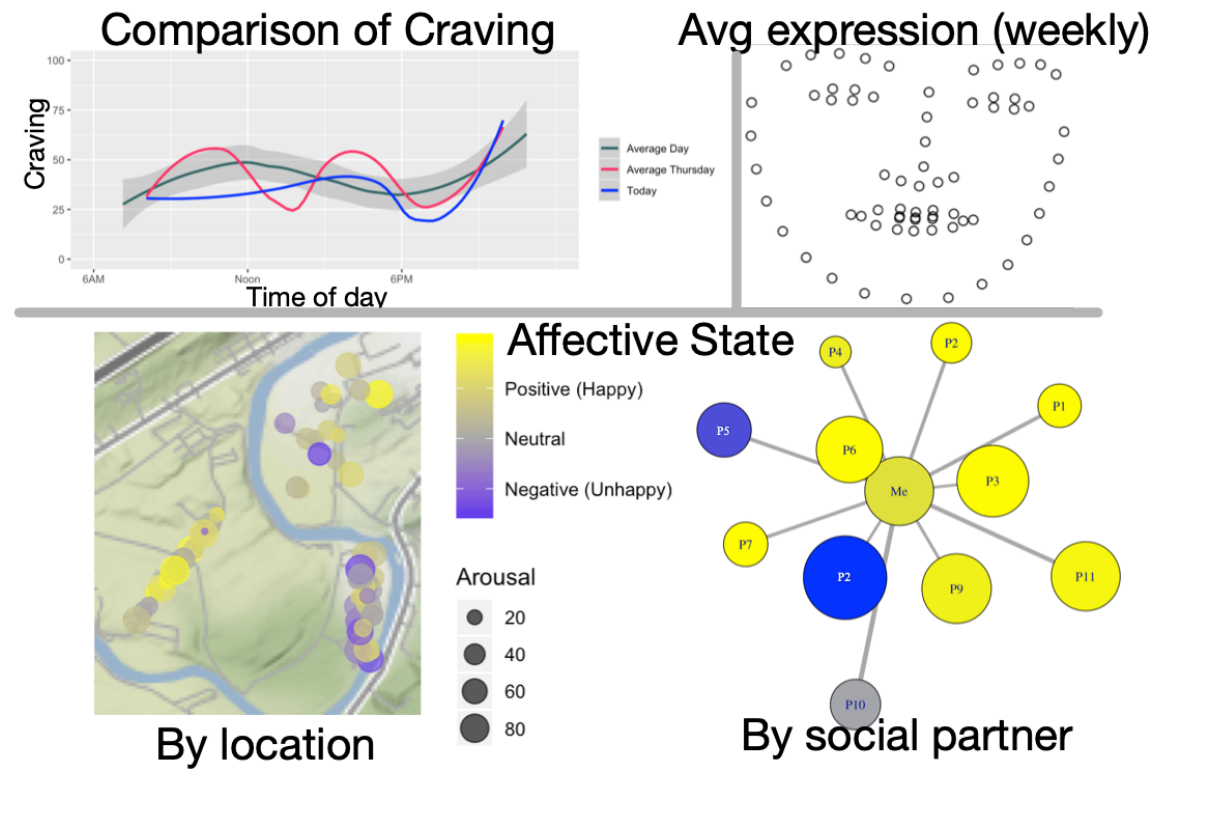
Figure 3. Example visualization of momentary affect and craving from